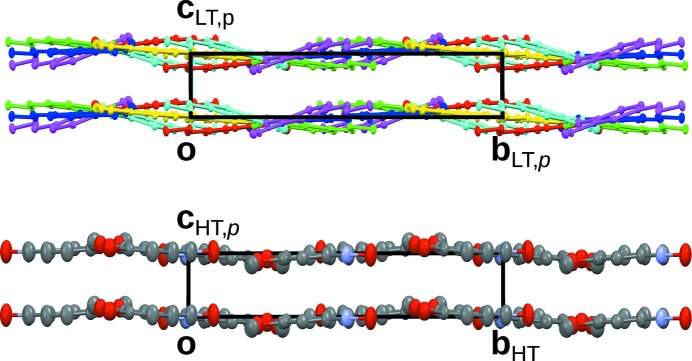
Comparison of (top) the LT phase and (bottom) the HT phase, viewed down [100]. Colours are as in Fig. 3 ▸. H atoms have been omitted for clarity.